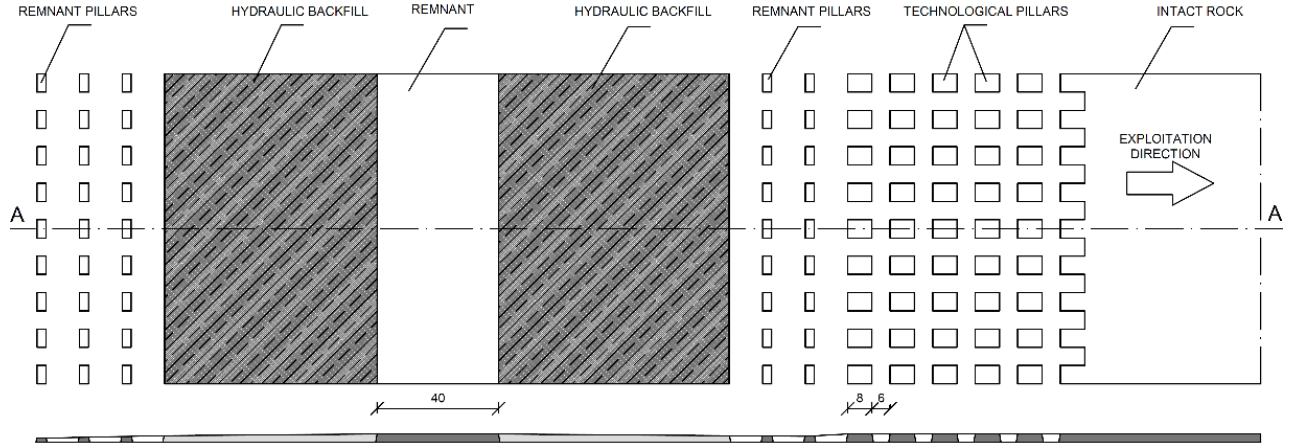
Figure 5. Scheme of room and pillar mining operations with the application of hydraulic backfill in the vicinity of the remnant .